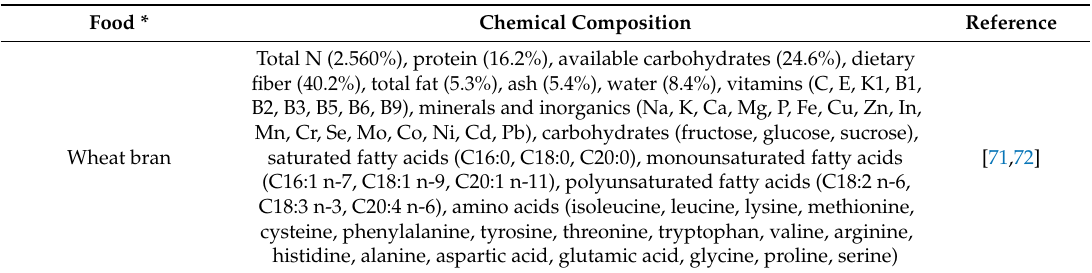
Table 4. Summary of chemical composition of various food materials and wastes which can be used for rearing edible insects (mainly adapted from DTU-Food database [71]). Food * Chemical